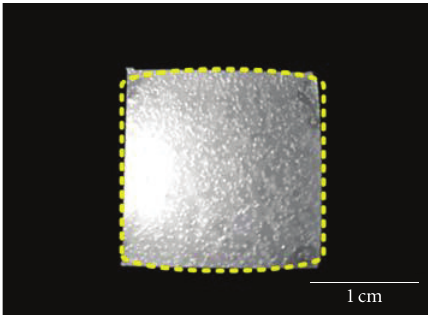
Figure 23: Microlens array with embedded microvoids optical film.